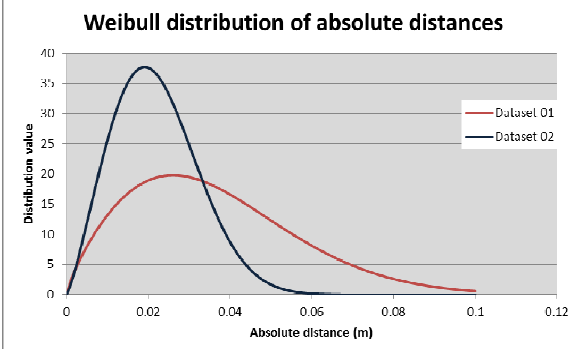
Figure 20: Comparison between photogrammetric point clouds and TLS one. Comparison made by CloudCompare (dataset 01)